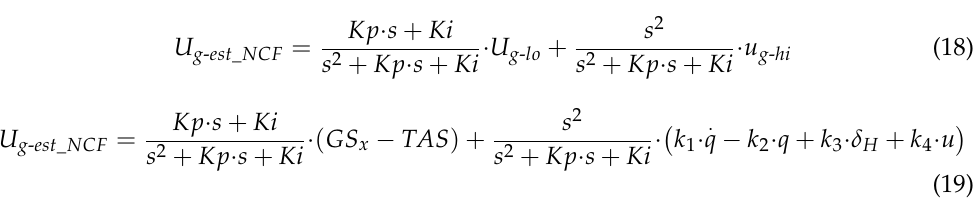
Figure 5. Bode diagram (amplitude and phase) for non-linear CF. Taking into consideration dependencies (1), (2), (12), (13) and (17), the complete law of headwind estimation (including temporary gusts) can be formulated as (18), and finally, as Equation